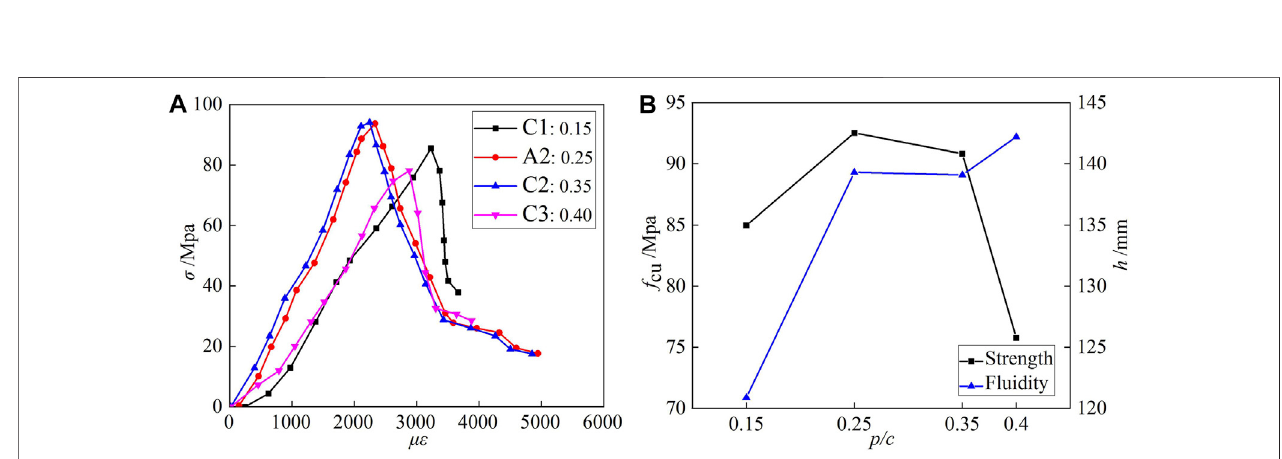
FIGURE 7 | The in fl uence of different ratios of slag powder to cement on RPC mechanical properties. (A) Stress-strain curves of RPC specimens with different ratios of slag powder to cement; (B) ultimate compressive strength and mixture fl uidity of RPC with different ratios of slag powder to cement.